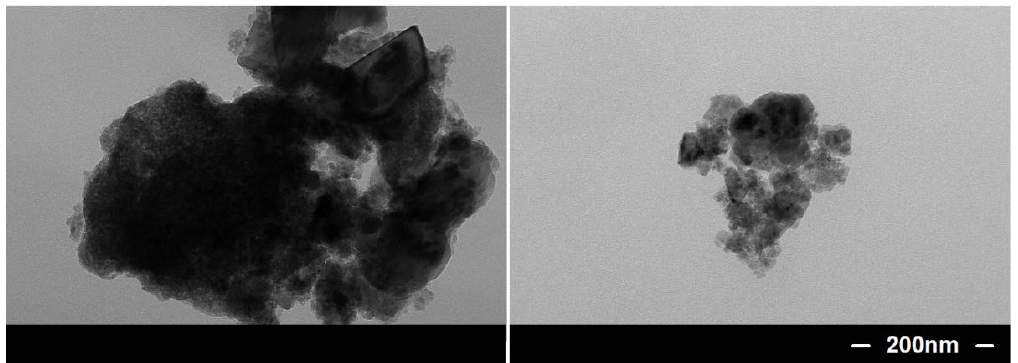
Figure 2. FESEM images of SSM ( a , d ), Fe 2 O 3 -NCs@SSM ( b , e ), OTS@Fe 2 O 3 -NCs@SSM ( c , f ).